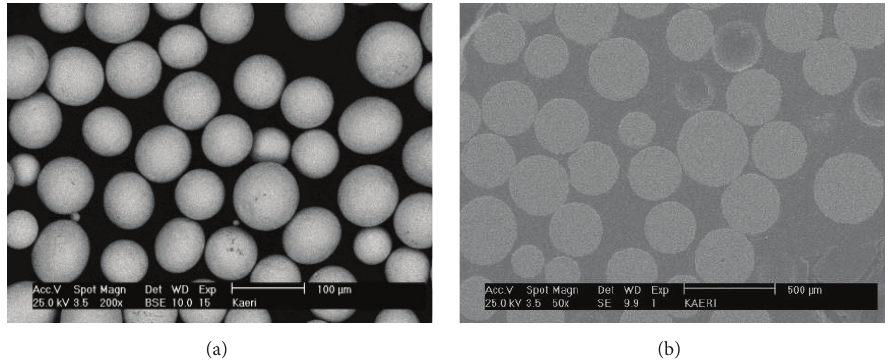
Figure 2: (a) 3D morphology of centrifugal atomized particles and (b) cross section view.